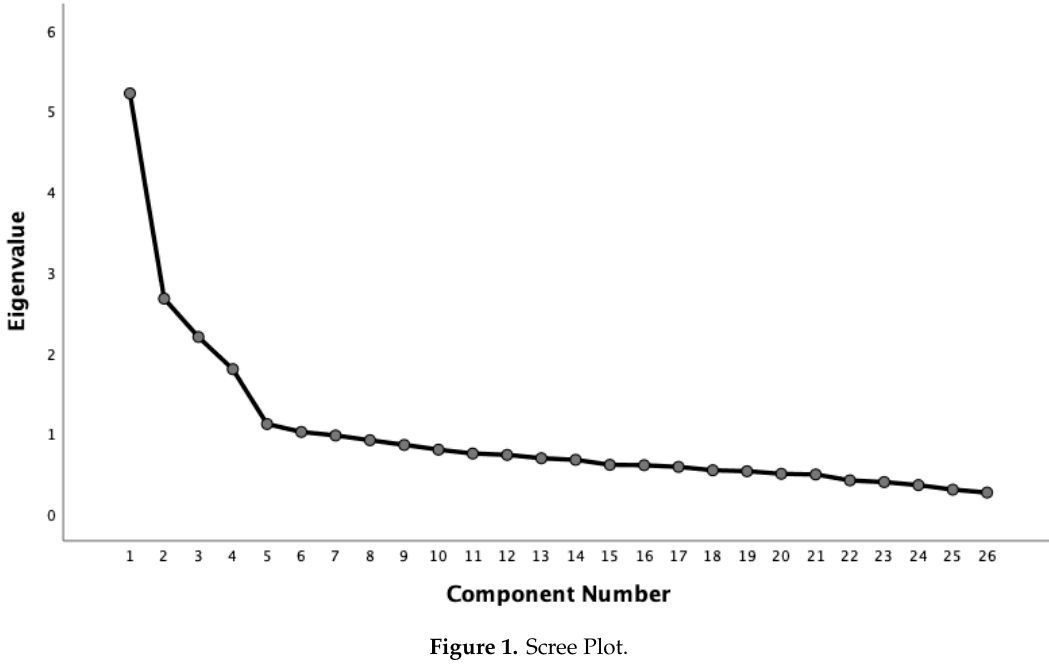
Figure 1. Scree Plot.